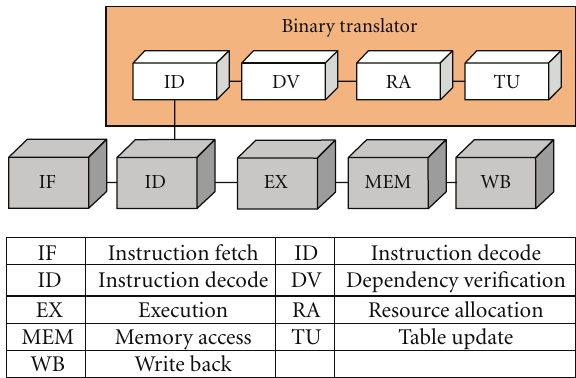
Figure 4: Binary translator’s pipeline coupled to the processor’s